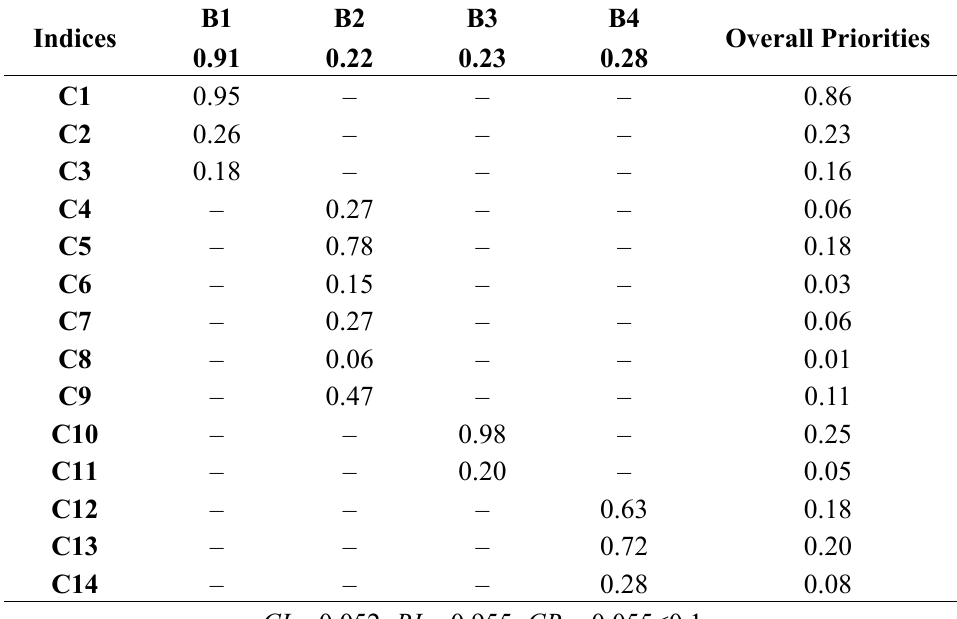
Table 7. Overall weight of the ecosystem stability evaluation